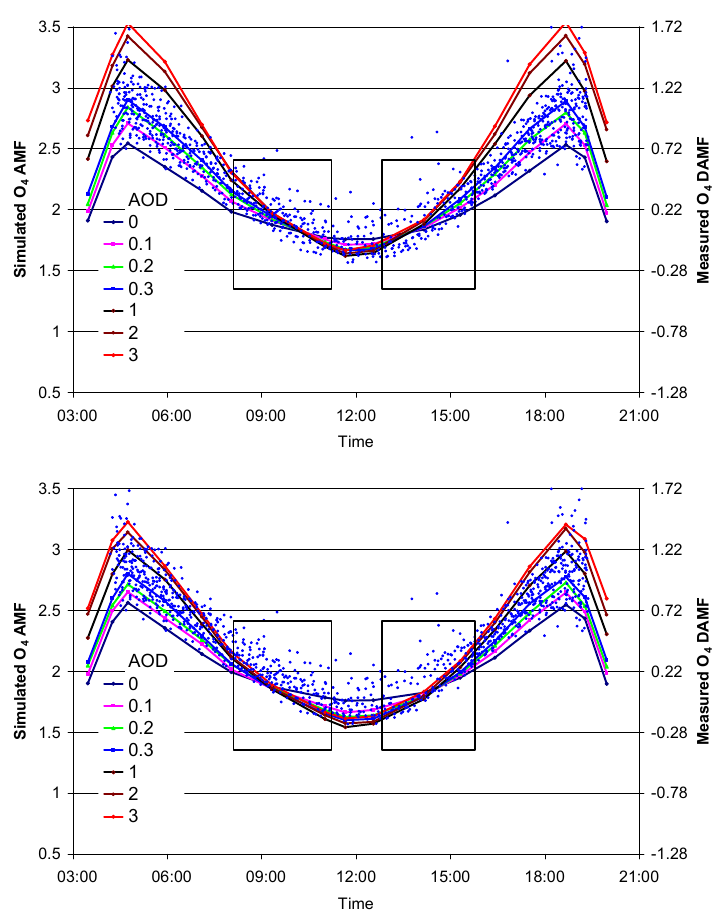
Figure A1. Comparison of measured O 4 DAMFs (only clear-sky observations, right axis) with simulated O 4 AMFs (left axis) for clear-sky conditions and different AOD (top: aerosol layer height of 500m; bottom: aerosol layer height of 2000m). The rectangles indicate the SZA ranges (30–50 ◦ ), which are used for the calibration of the O 4 measurements. The measurements are from the period 12 June to 15 July 2009; the simulations are performed for a day (26 June 2009) in the middle of the